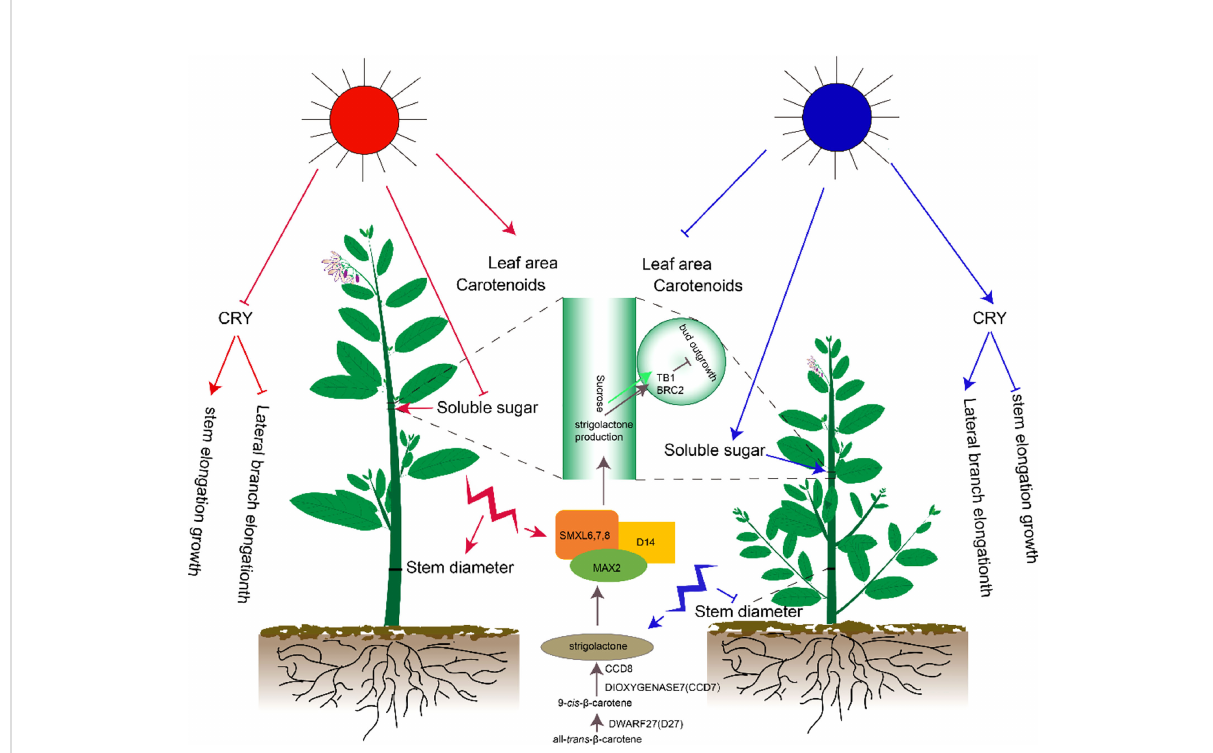
FIGURE 7 Effects of different light quality treatments on phenotypes, physiology, and gene expression of